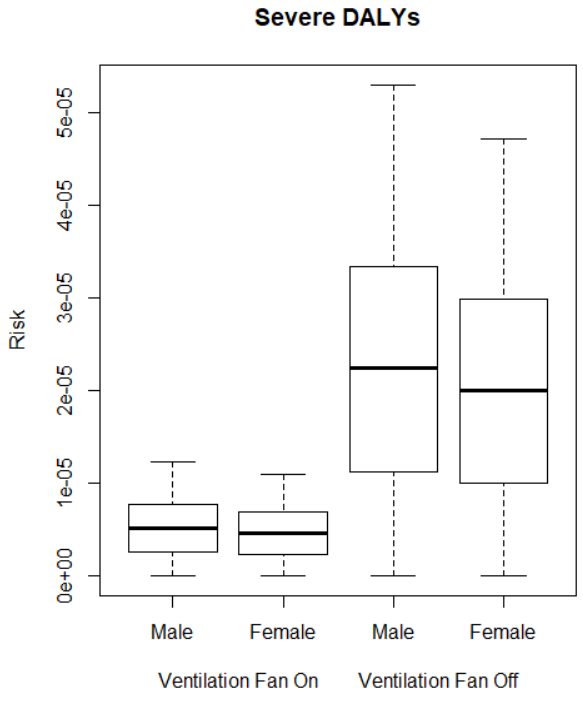
Figure 4. Severe DALYs for male and female miners.